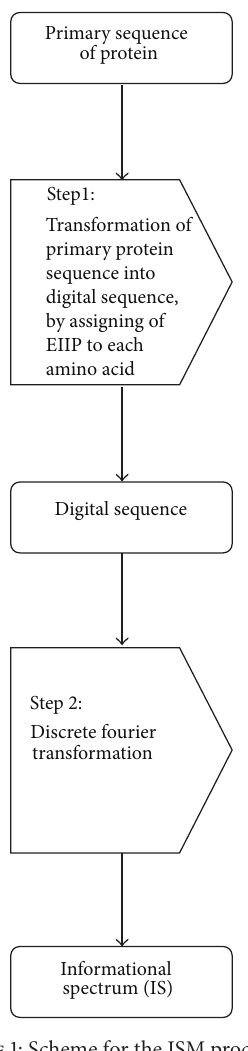
Figure 1: Scheme for the ISM